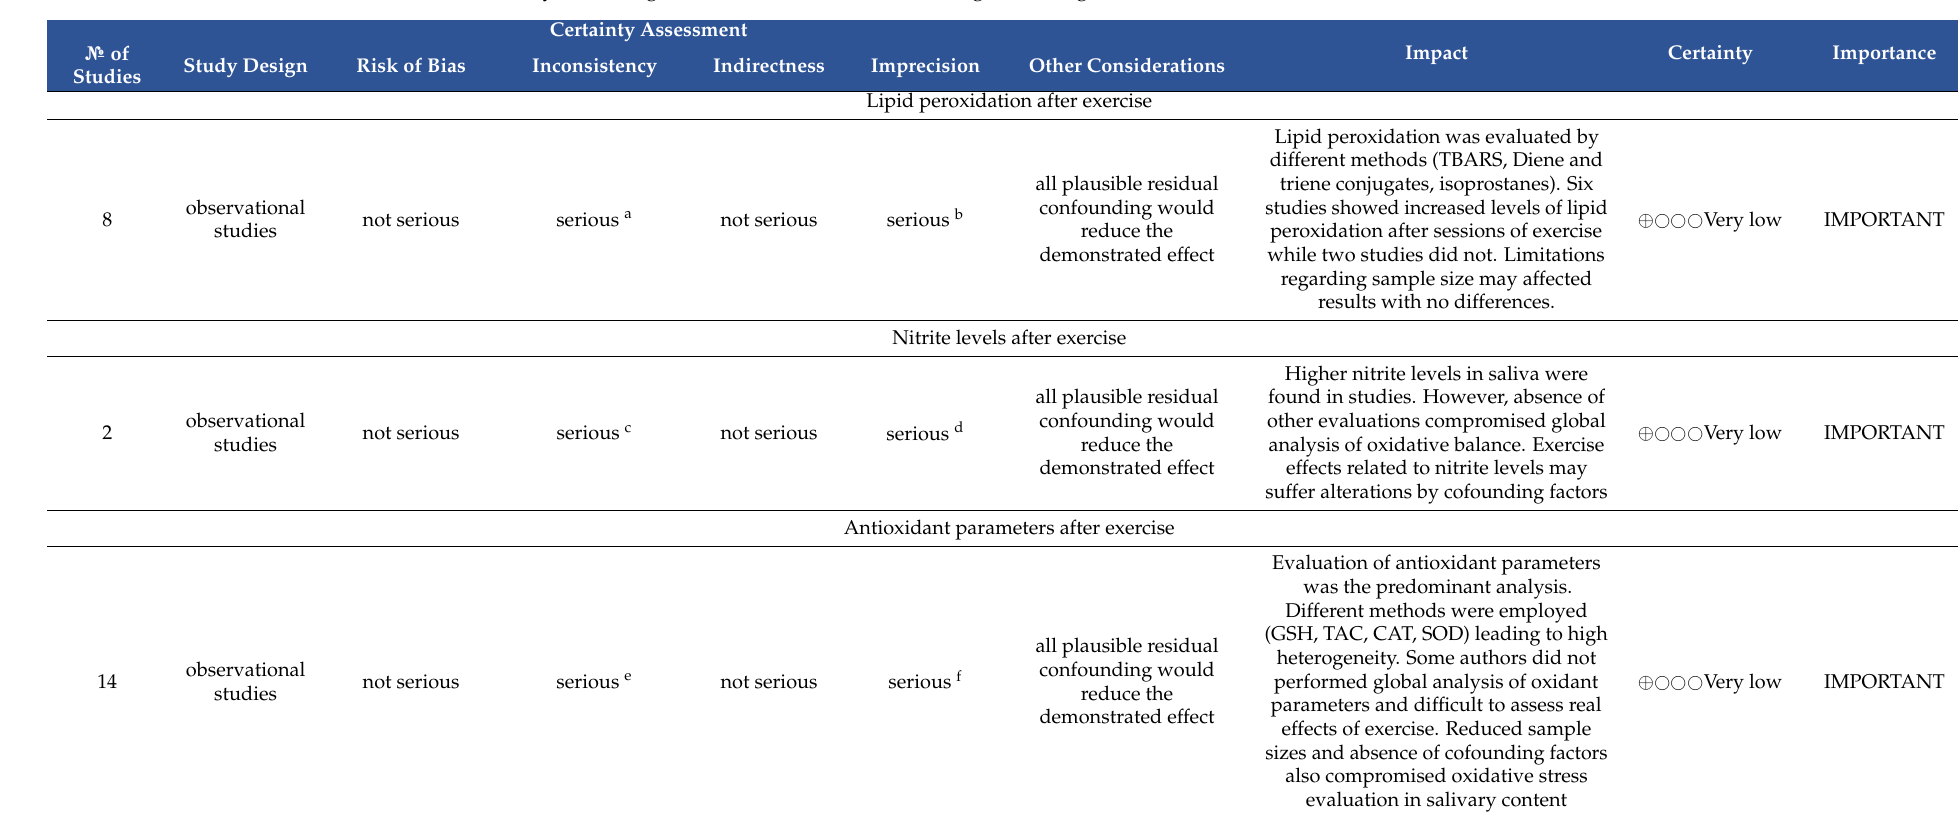
Table 3. Summary of findings and level of evidence following GRADE